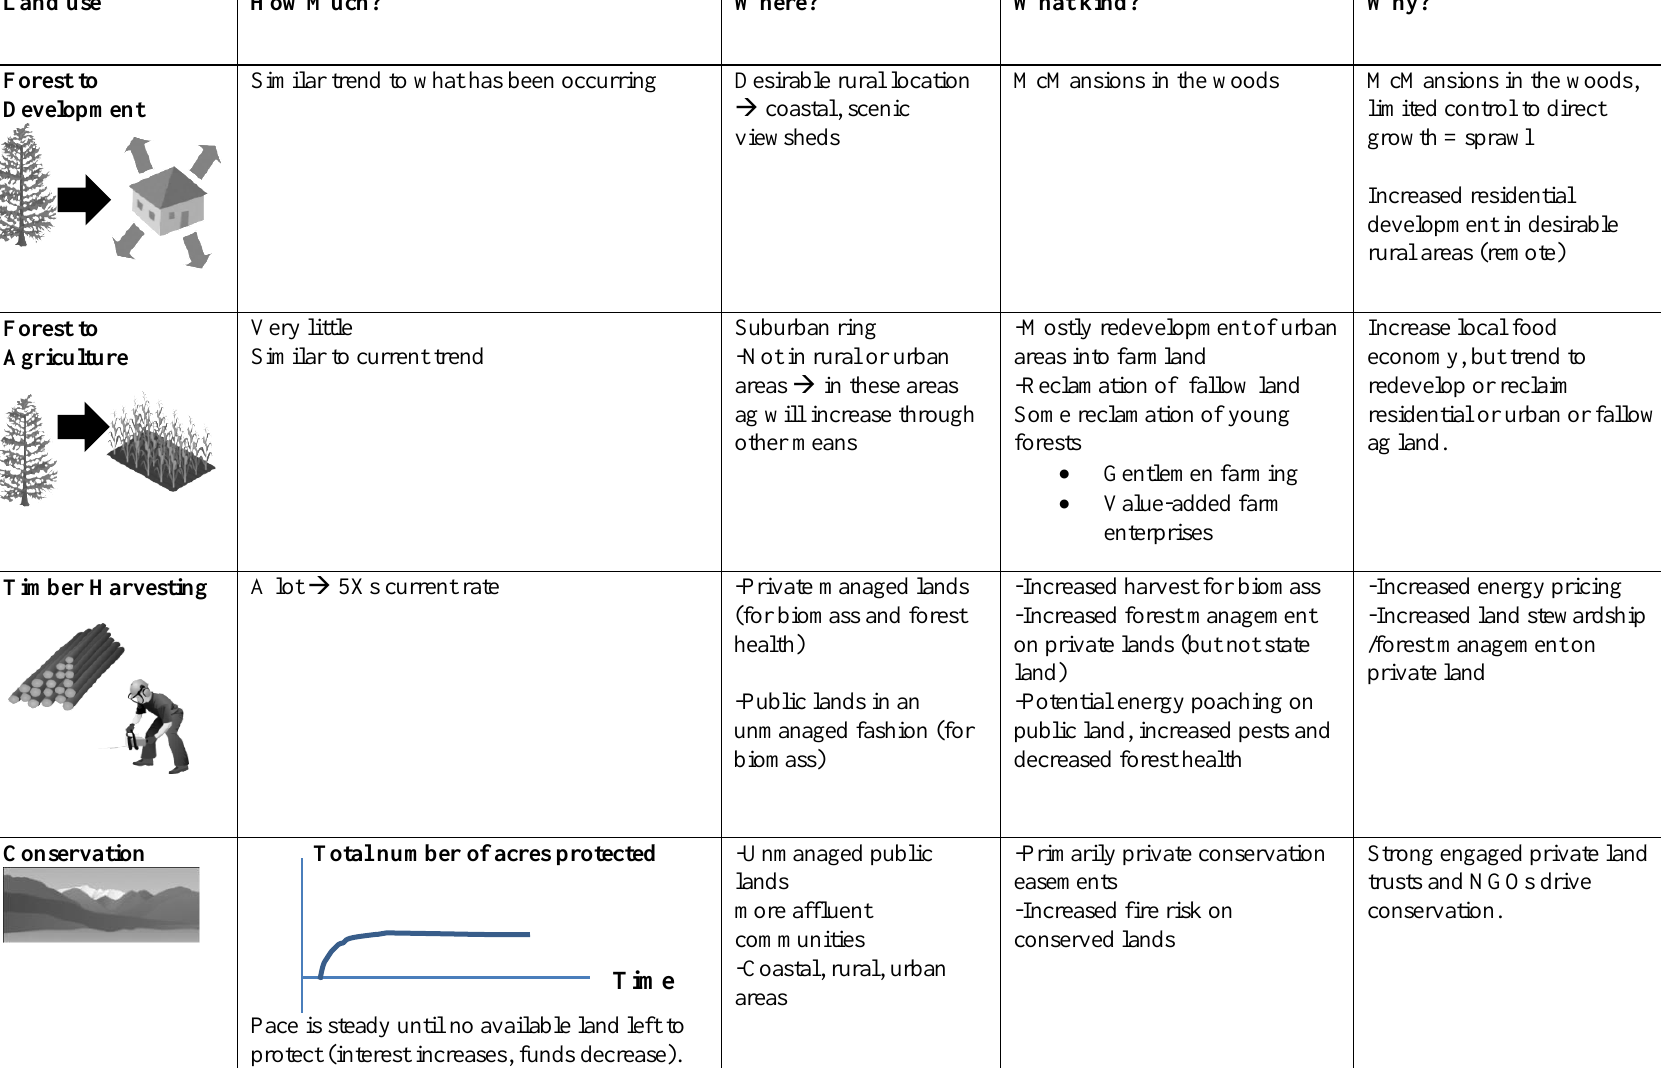
Table A2.17. Scenario 1: Pay to